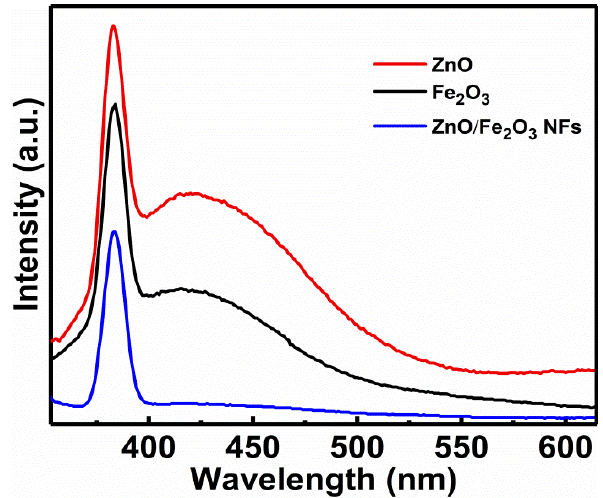
Figure 8. PL spectra of the as-prepared samples as indicated.